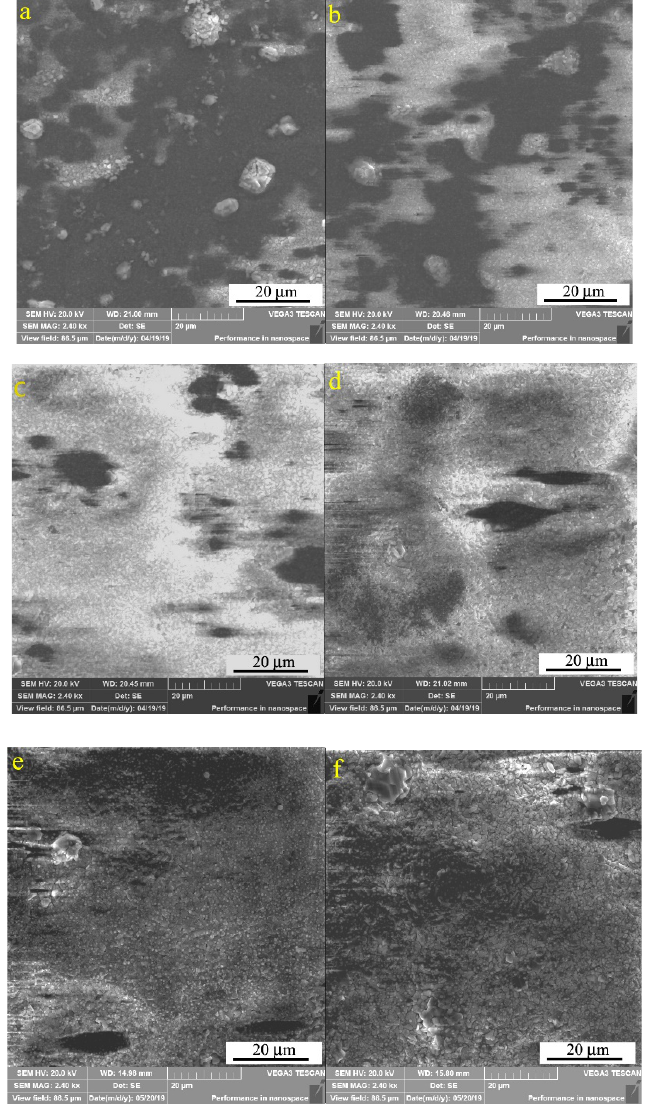
Figure 4. Surface morphologies of samples treated at different temperatures for 3 h: ( a ) 1220 °C, ( b )